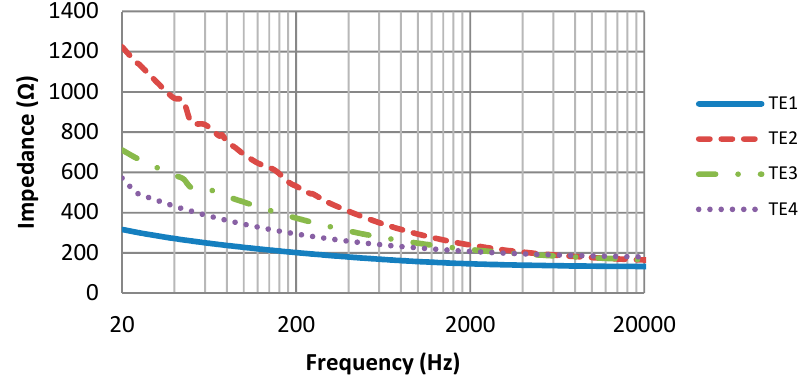
Figure 6. Skin-electrode impedance versus frequency.